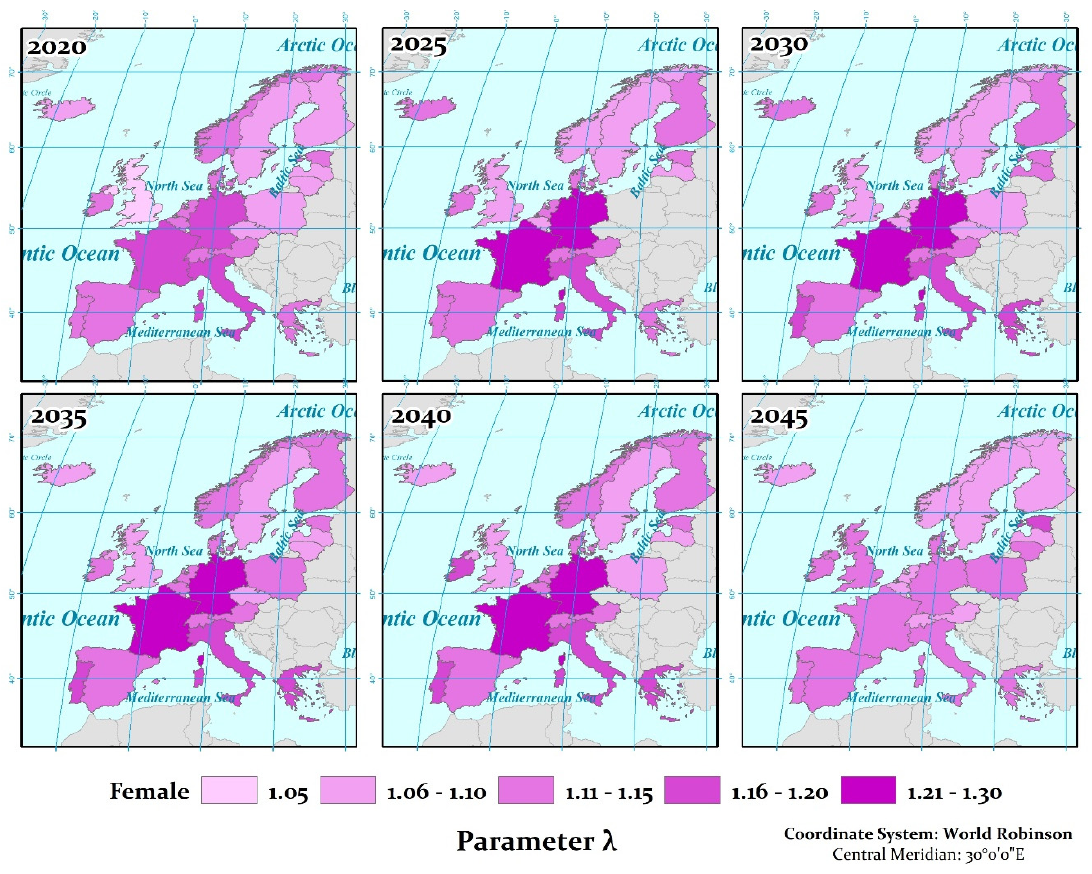
Figure 5. The projected values of random risk factor for the 22 EU countries (arameter λ —female).